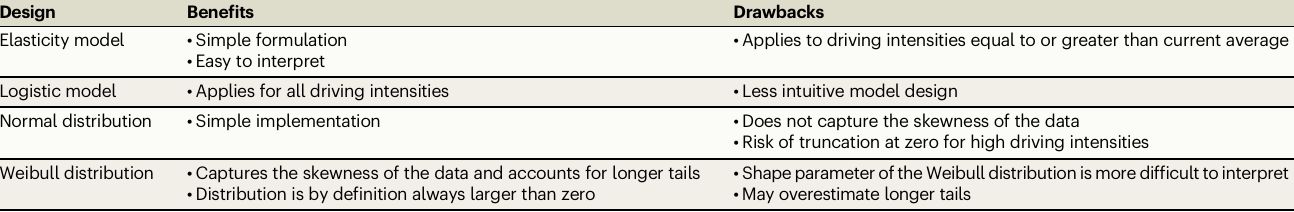
Table 1 | Bene fi ts and drawbacks different semi-empirical model designs